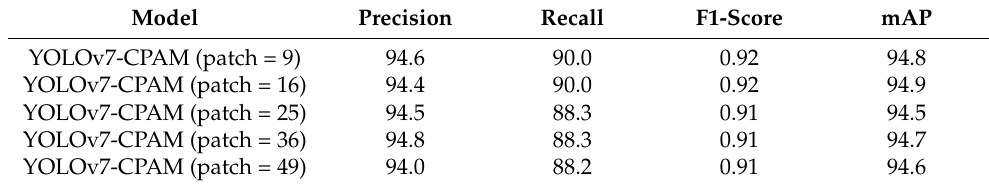
Table 7. The results of CPAM with different patch